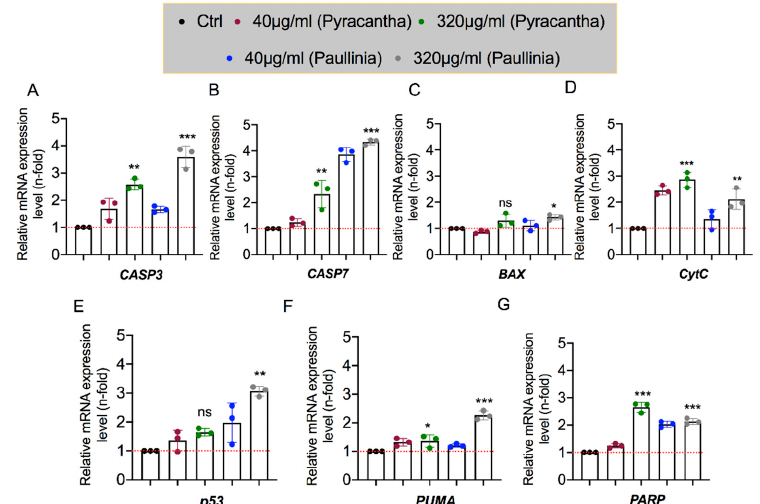
Figure 7. Pyracantha and Paullinia induce apoptosis in cancer cells. ( A and B ) Caspase-3/7 activity was measured in MDA-MB231 and HEPG2 cells treated with two different concentrations (40 or 320 µg.ml –1 ) of Pyracantha and Paullinia extracts, respectively. ( C and D ) Caspase-9 activity was measured in MDA-MB231 and HEPG2 cells treated with two different concentrations (40 or 320 µg.ml –1 ) of Pyracantha and Paullinia extracts, respectively.* p < 0.05; ** p < 0.01. Untreated samples were used as controls for all tested plant extracts.